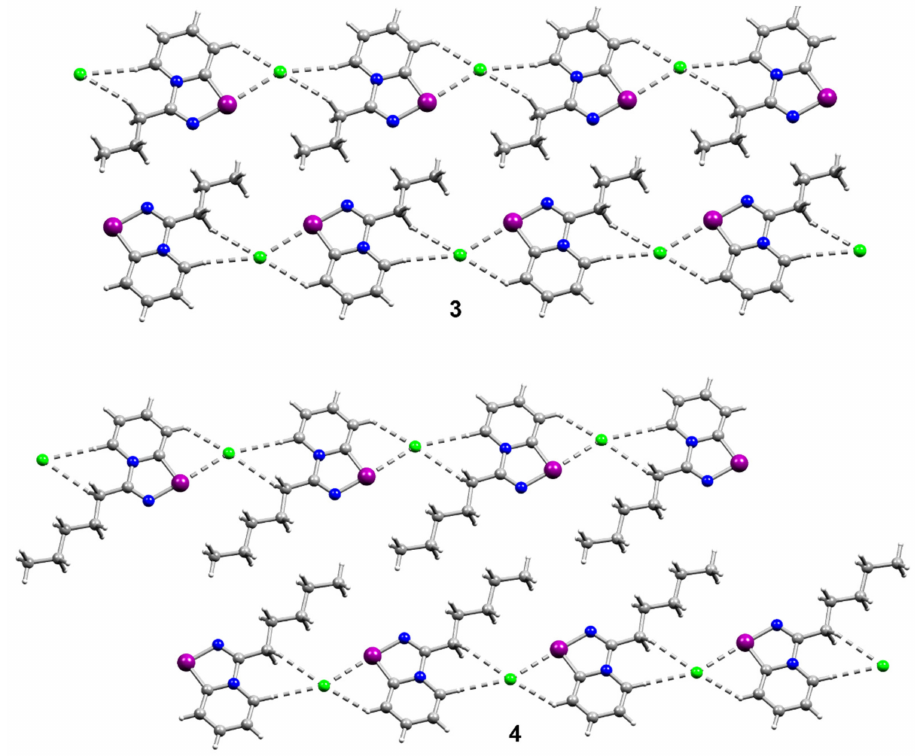
Figure 2. Ball-and-stick representations of the crystal structures of 3 and 4 , demonstrating their self-assembly into 1-D supramolecular polymers via Se ··· Cl and H ··· Cl interactions. Green, purple, blue, grey, and light-grey spheres represent chlorine, selenium, nitrogen, carbon, and hydrogen,